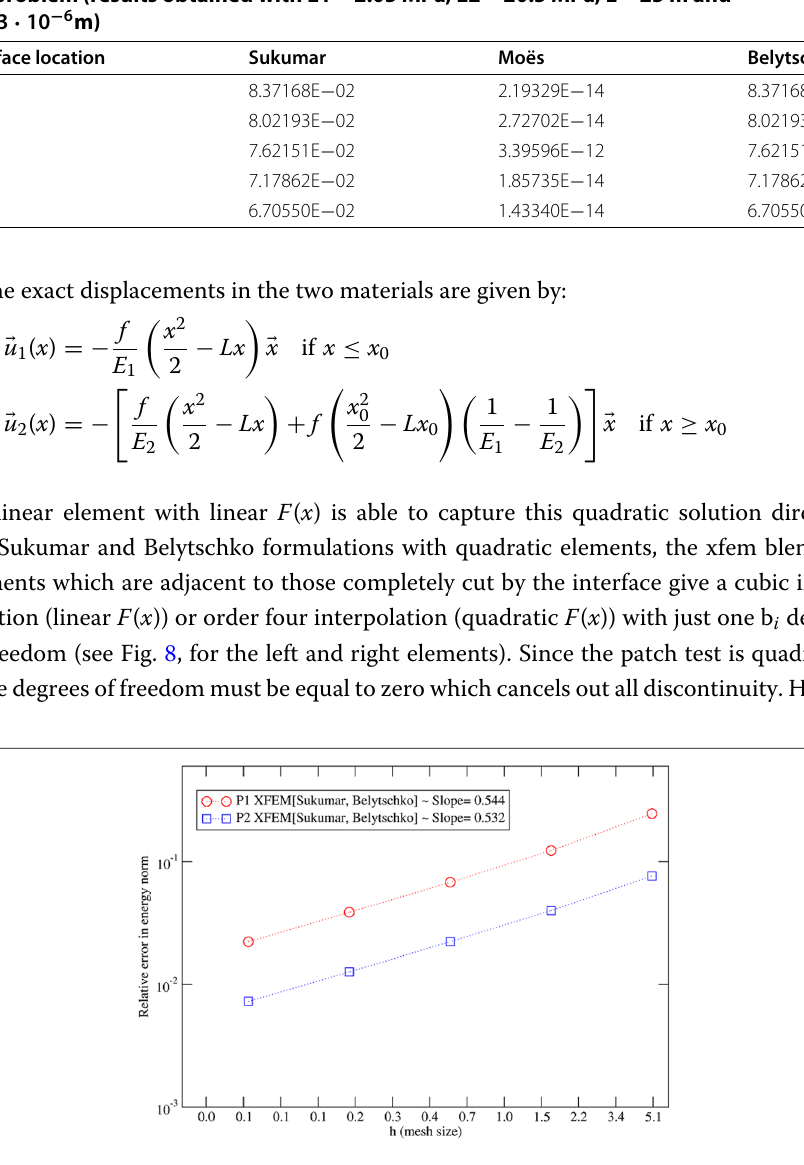
Fig. 38 Convergence in energy norm at a rate of 0.5 [44] for Sukumar and Belytschko enrichments. These results are obtained with E1 = 2.05 MPa, E2 = 20.5 MPa, L = 25 m and ¯ u = 3 . 10 − 6